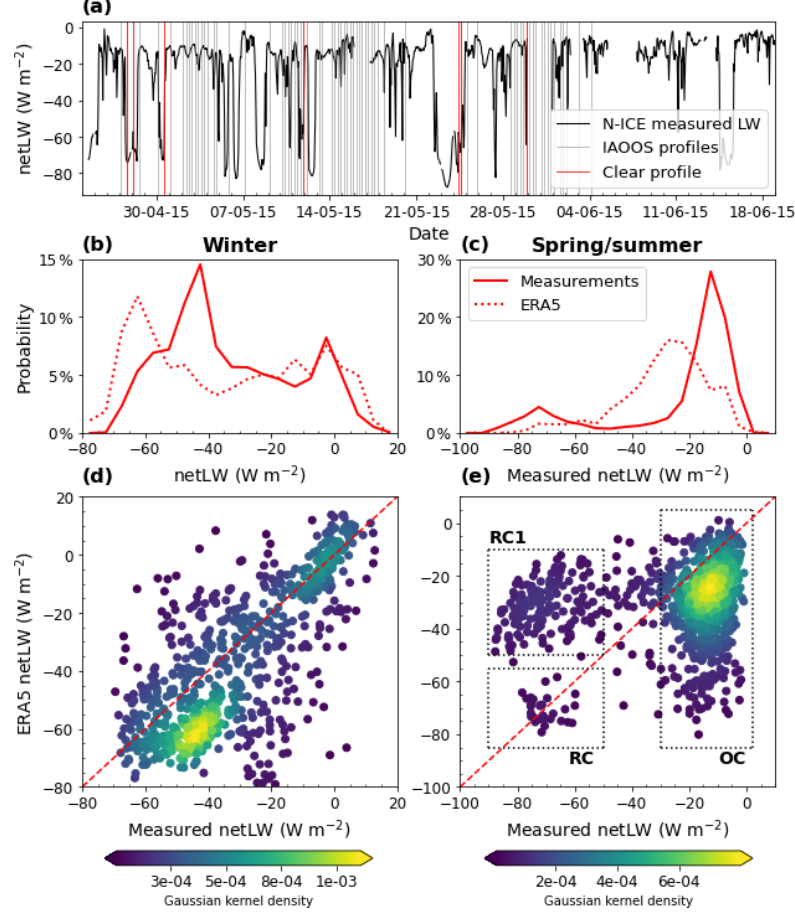
Figure 5. (a) Time series of surface net longwave measurements during the N-ICE field experiment (second period, April–June 2015). The vertical lines indicate the time of IAOOS lidar profiles, with red lines corresponding to cloudless profiles. (b, c) Histogram of the measured (filled line) and ERA5 (dashed line) net longwave flux during the N-ICE winter (b) and spring/summer (c) campaign periods. (d, e) Hourly ERA5 vs. measured net longwave during the N-ICE winter (d) and spring/summer (e) campaign periods, with the red dashed line indicating the 1 : 1 line. The colour corresponds to point density as calculated by a Gaussian kernel. For panel (e) , three zones have been outlined. Zone “OC” contains points belonging to the opaquely cloudy mode of the measured netLW distribution. Zones “RC1” and “RC2” contain points belonging the radiatively clear mode of the distribution in April and May (RC1) and June